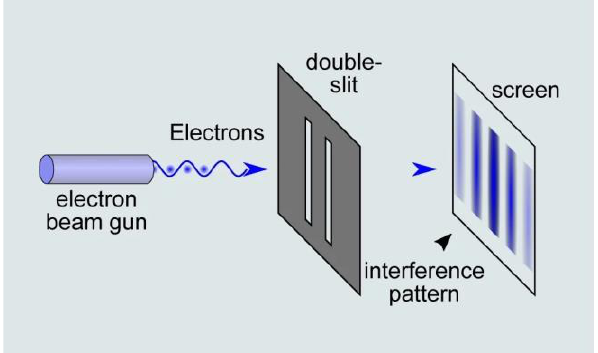
Figure 2. The double-slit experiment illustrates the wave – paticle duality of light. An electron beam consisting of one or multiple electrons is presented in front of a double slit, which produces an interference pattern. Although the electron is a particle, it behaves as a wave in this situation. (source: https://naturenoon.com/double-slit-experiment-simple, accessed on 20 December 2022).